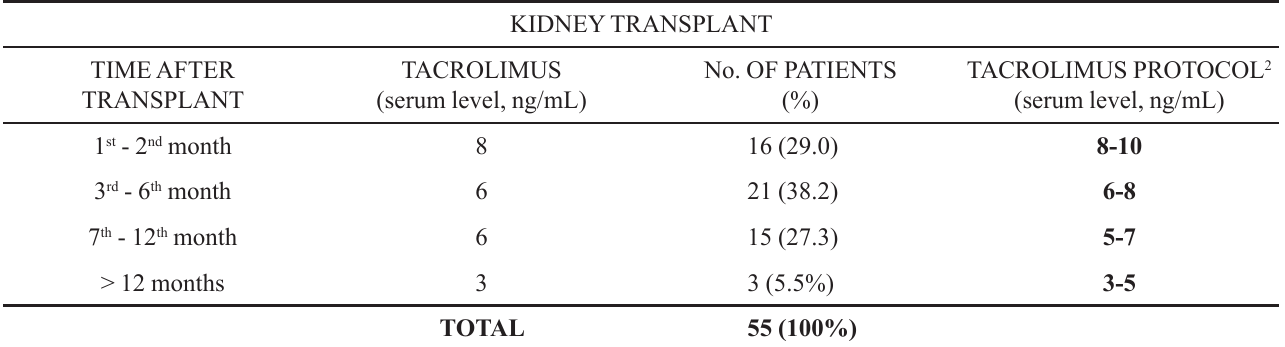
TABLE IV - Serum levels of calcineurin inhibitor (Tacrolimus) of kidney transplant patients seen by the Pharmaceutical Care Service. April - October/2011, Fortaleza - Ceará KIDNEY TRANSPLANT TIME AFTER